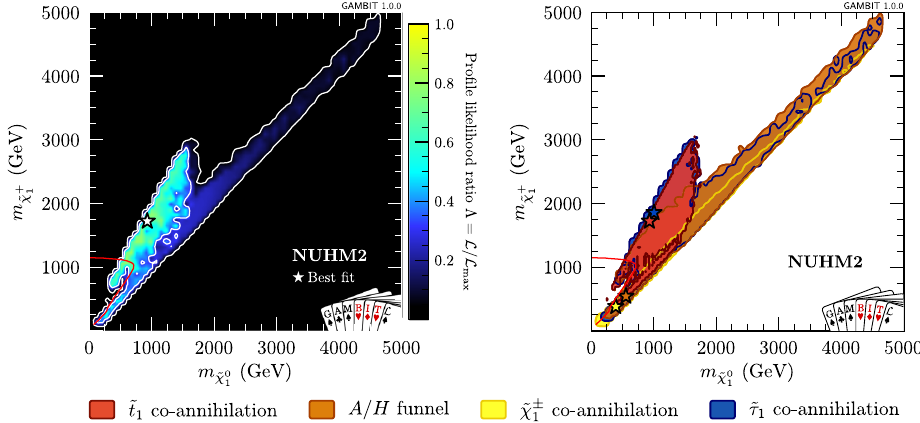
− ˜ χ 0 mass of DM. Superimposed in red is the latest CMS Run II simplified model 1 1 limit for ˜ χ ±